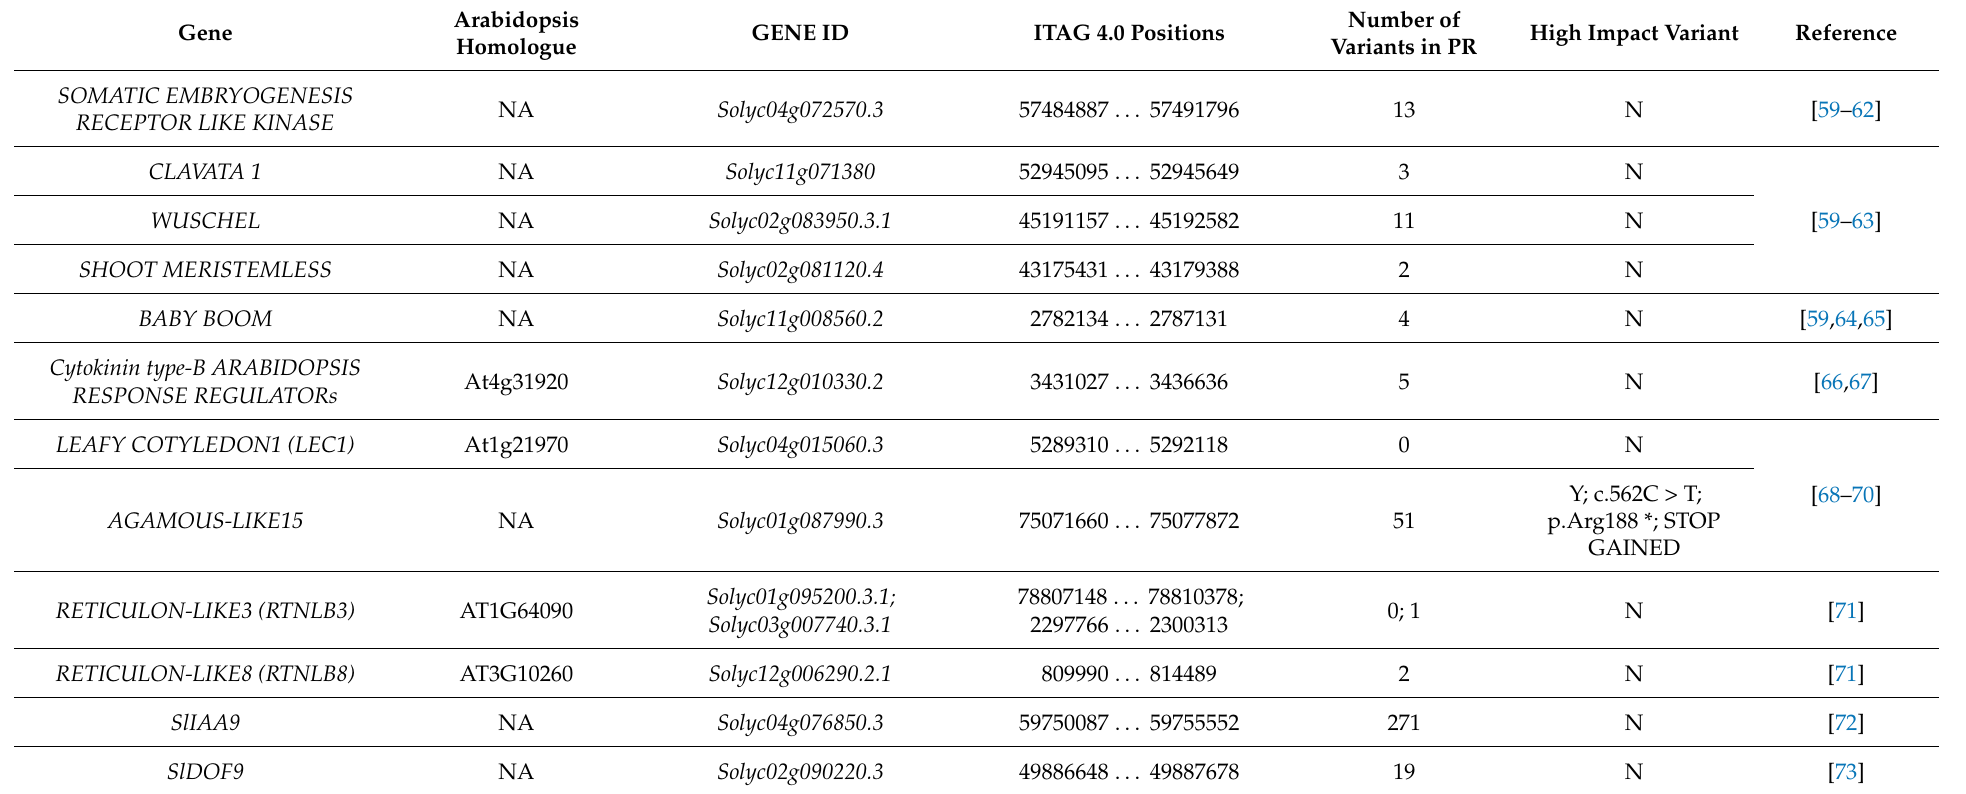
Table 4. Allele mining of genes involved in regeneration process or totipotency and cell fate in S. lycopersicum cv. Pusa Ruby. Arabidopsis Gene GENE ID ITAG 4.0 Positions Homologue